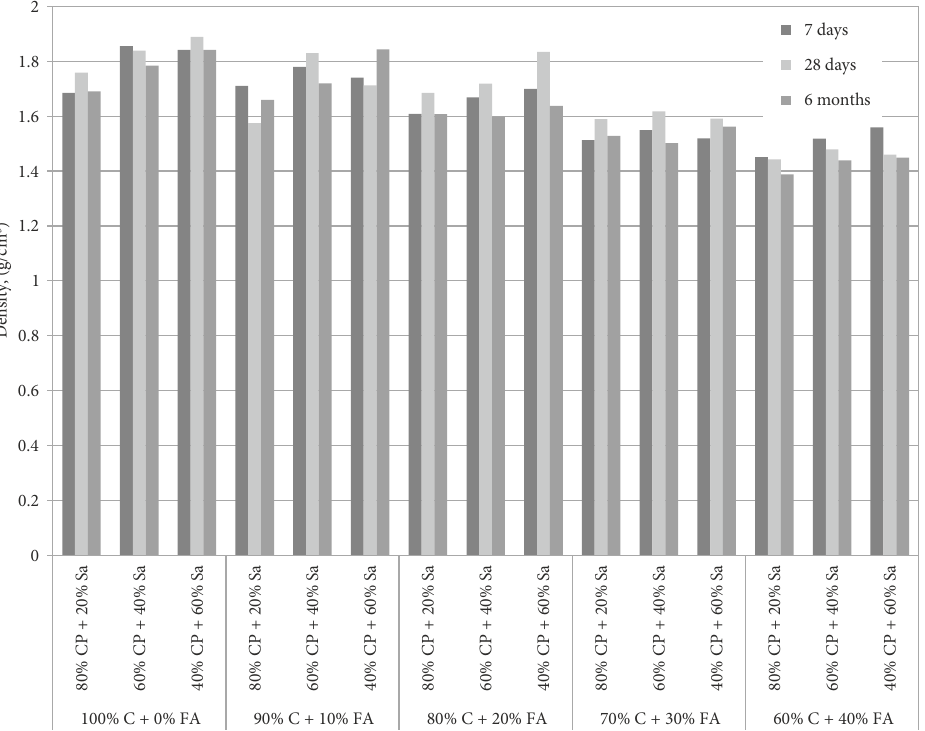
Figure 4. Density of investigated